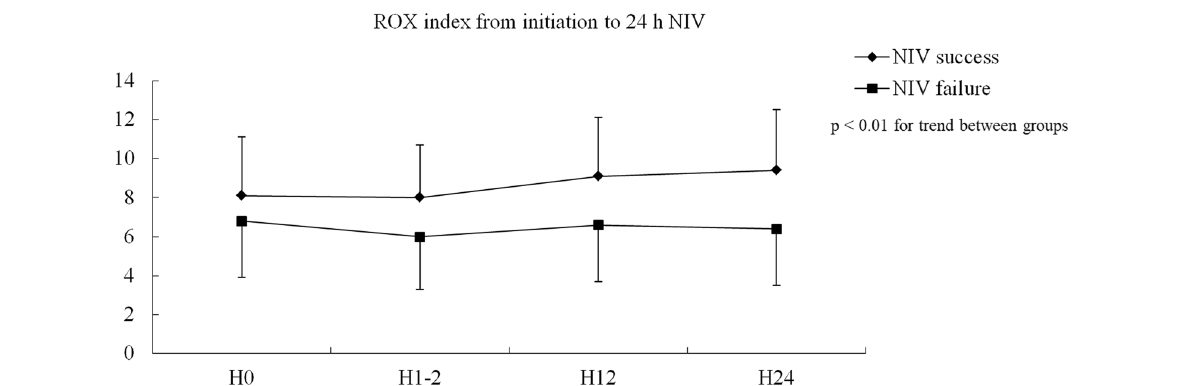
Fig. 2 Comparisons in ROX index between patients with NIV success and failure. ROX SpO 2 /FiO 2 to respiratory rate, NIV noninvasive ventilation